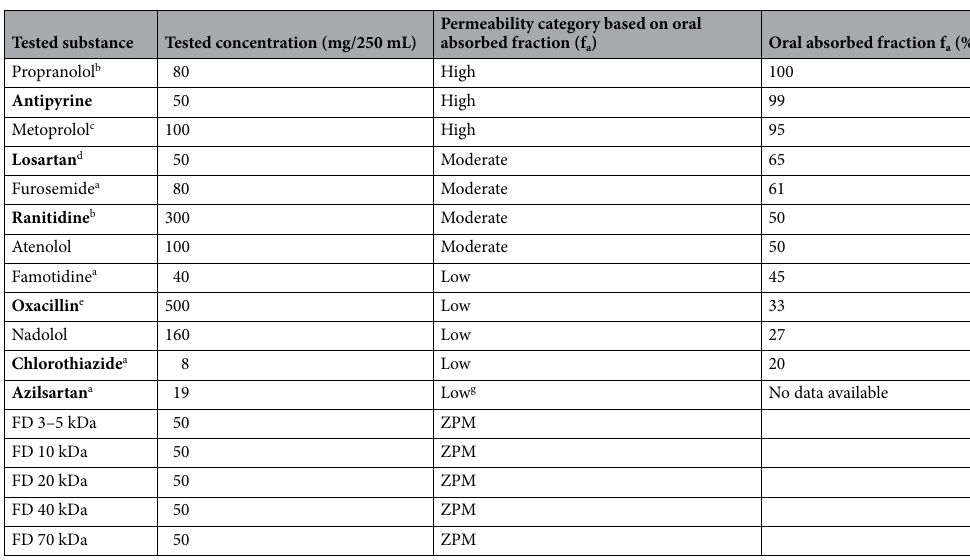
Table 1. Summary of doses used for testing permeability of model drugs and zero permeability markers (ZPM), dissolved in 250 mL assay buffer. The permeability of all model drugs and zero permeability markers was tested in FLO-1 cells cultured in DMEM, while several model drugs (in bold) were also tested in FLO-1 cells cultured in A-DMEM. a DMSO used for preparing solutions of model drugs (maximum 1% DMSO in the final solution). b Tested substances used in their hydrochloride salt form. c Substance tested as metoprolol tartrate. d Substance tested as losartan potassium. e Substance tested as oxacillin sodium monohydrate. f Reference 33 . g Reference 54